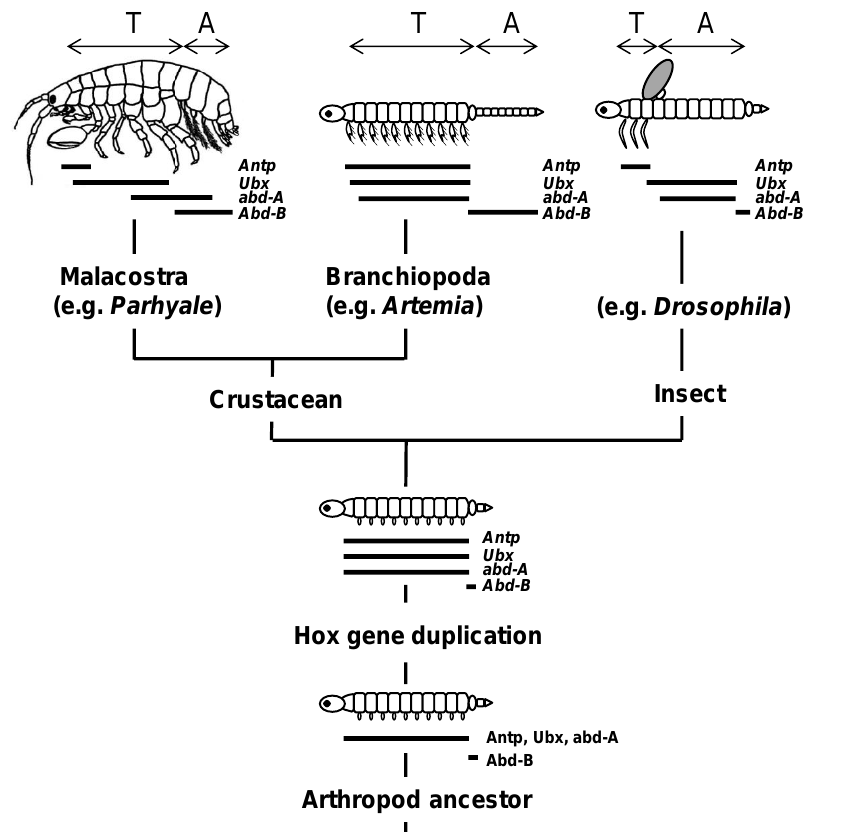
Figure 11. Hox expressions in arthropods. Figure drawn mainly from Abzhanov and Kaufman [94], Averof and Akam [91], Serano et al . [17] and McCarthay-Taylor et al. [92]. T, thorax; A, abdomen. Figure from Gaunt 2019 [6].